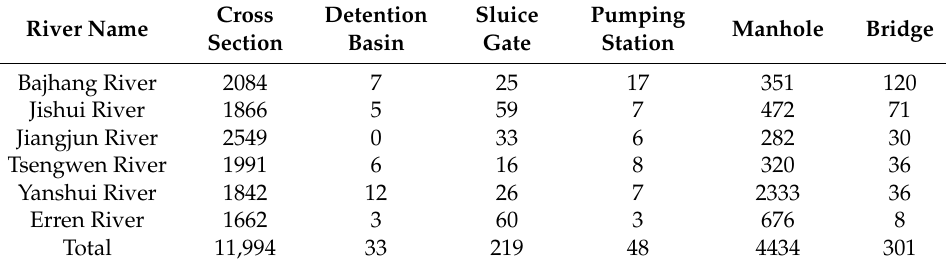
Table 3. Amount of hydraulic structures in six rivers of Tainan City.